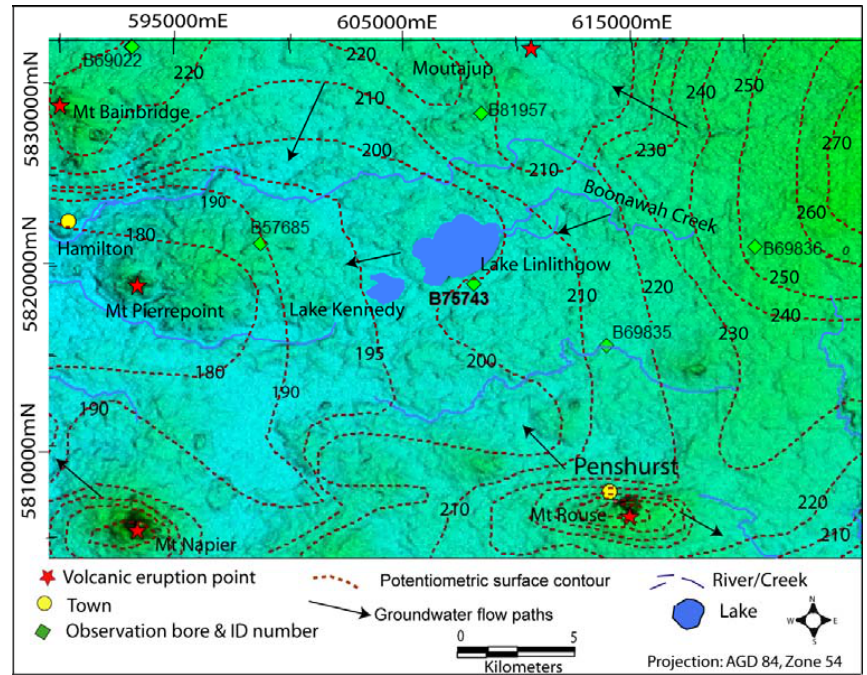
Figure 4. Lake Linlithgow and associated wetlands (gray) and basalt aquifer potentiometric surface contours (m AHD).